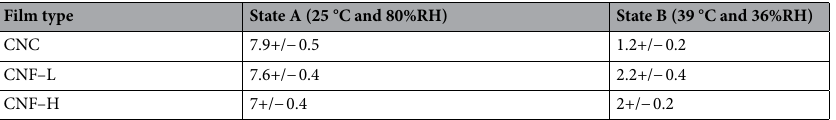
Table 3. Film swelling, S (Eq. 1), after t = 168 h at either state A or state B. Both states correspond to an absolute humidity of ~ 0.018 kg/m 3 water. The reported errors are standard